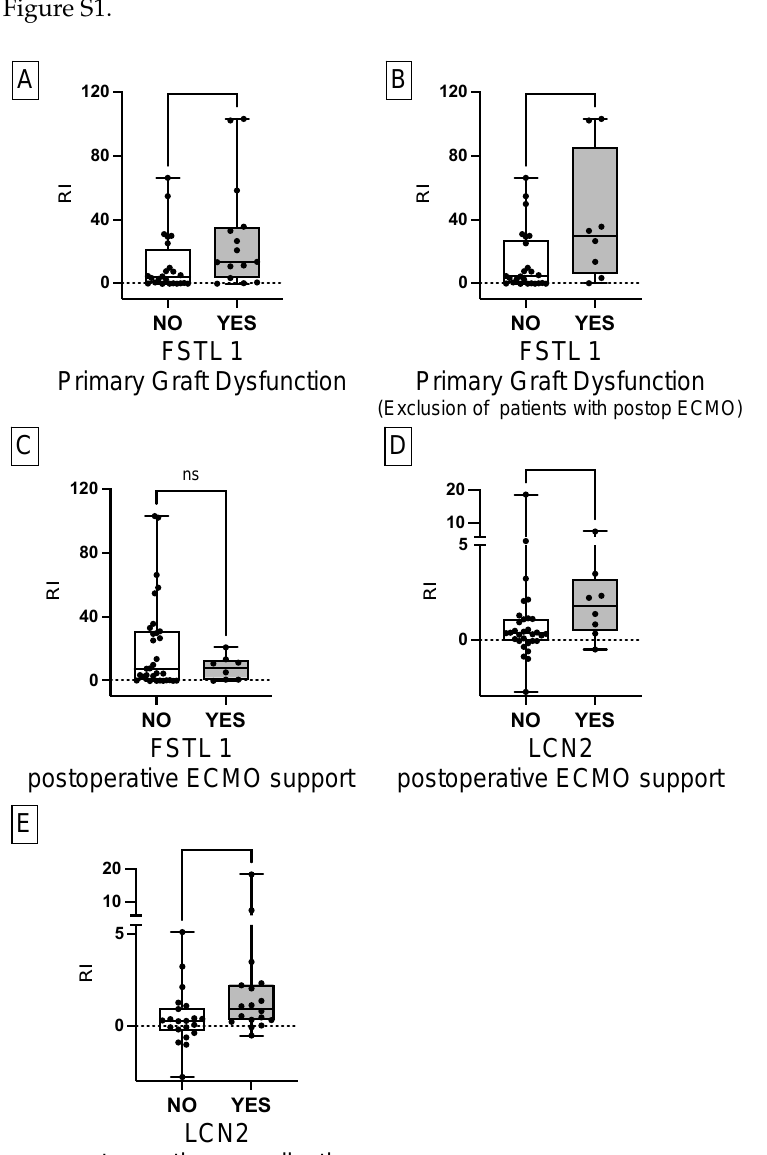
Figure 2. Increased cytokine serum concentrations in patients requiring prolonged ECMO, devel- oping complications and PGD. ( A ) Significantly increased FSTL1 RI in patients developing PGD. ( B ) Significantly increased FSTL1 RI in patients developing PGD after exclusion of patients on postoperative ECMO support. ( C ) No difference in FSTL1 RI between patients with compared to patients without postoperative ECMO support. ( D ) Significantly increased LCN2 RI in patients with prolonged postoperative ECMO support. ( E ) Significantly increased LCN2 RI in patients with com- plications comprising hemofiltration, re-intubation, surgical revision, and 30-day mortality. ECMO, extracorporeal membrane oxygenation; FSTL1, follistatin-like 1; LCN2, lipocalin 2; ns, not significant; PGD, primary graft dysfunction; relative increase,